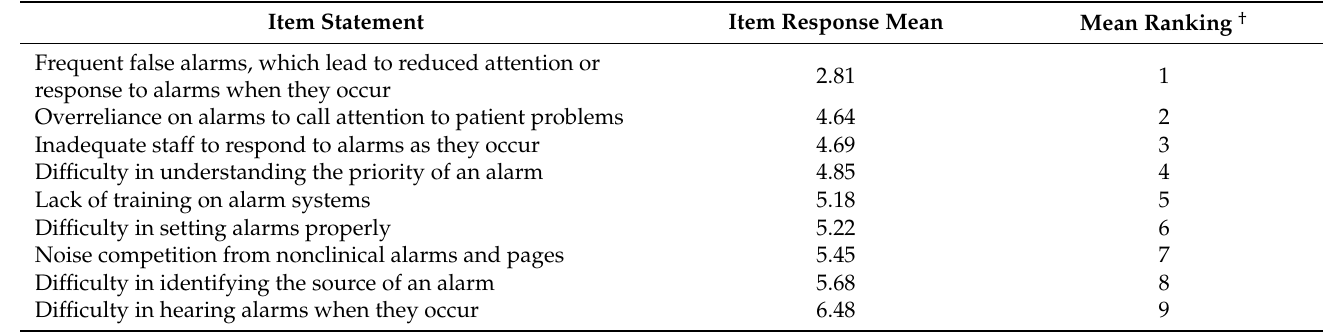
Table 2. Clinical alarm-related important issues (N = 116).